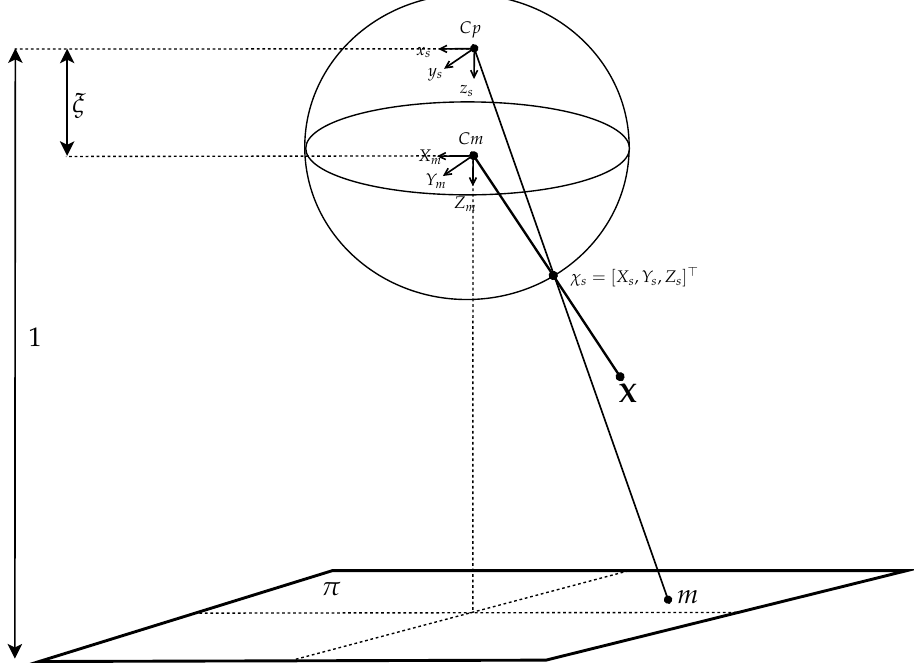
Figure 2. The unified sphere projection model for the catadioptric camera. Given a 3D point X , it is projected to a point on the unified sphere at χ s . This point is then projected to another point m on the image plane π via the new projection center at C p = ( 0, 0, ζ ) .